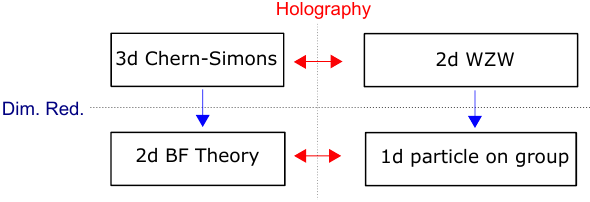
Figure 2 . The 3d Chern-Simons / 2d WZW holographic relation, which dimensionally reduces to the 2d BF / 1d particle-on-a-group